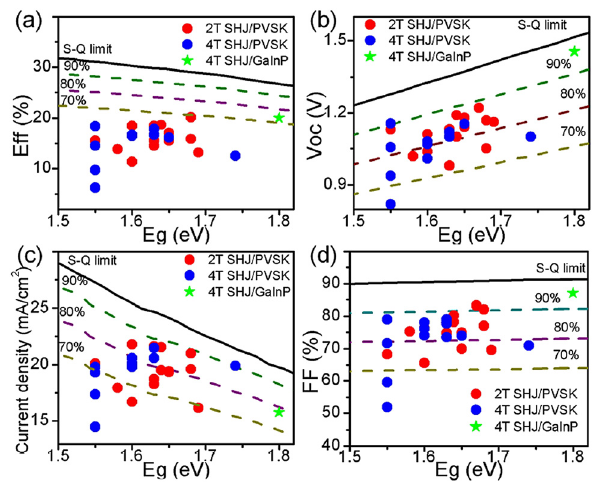
Figure 6: Record-efficiency top cell parameters as a function of band gap for 2T and 4T SHJ tandem devices. The red and blue spheres represent the record-efficiency cell parameters for 2T and 4T SHJ/ perovskite tandems respectively (see Tables 1 – 2 for references). The green star shows record-ef fi ciency GaInP cell parameters for 4T SHJ/ GaInP TSC [23]. The black line represents SQ limit for single junction solarcell.Thegreen,violetandlightgreendashedlinesrepresent90, 80 and 70% SQ limit for single junction solar cell respectively. (a) Power-conversion efficiency (PCE). (b) Open-circuit voltage ( V oc ). (c) Short-circuit current ( J sc ) and (d) Fill factor (FF). All data are for standard AM1.5 illumination at 1000 W/m 2